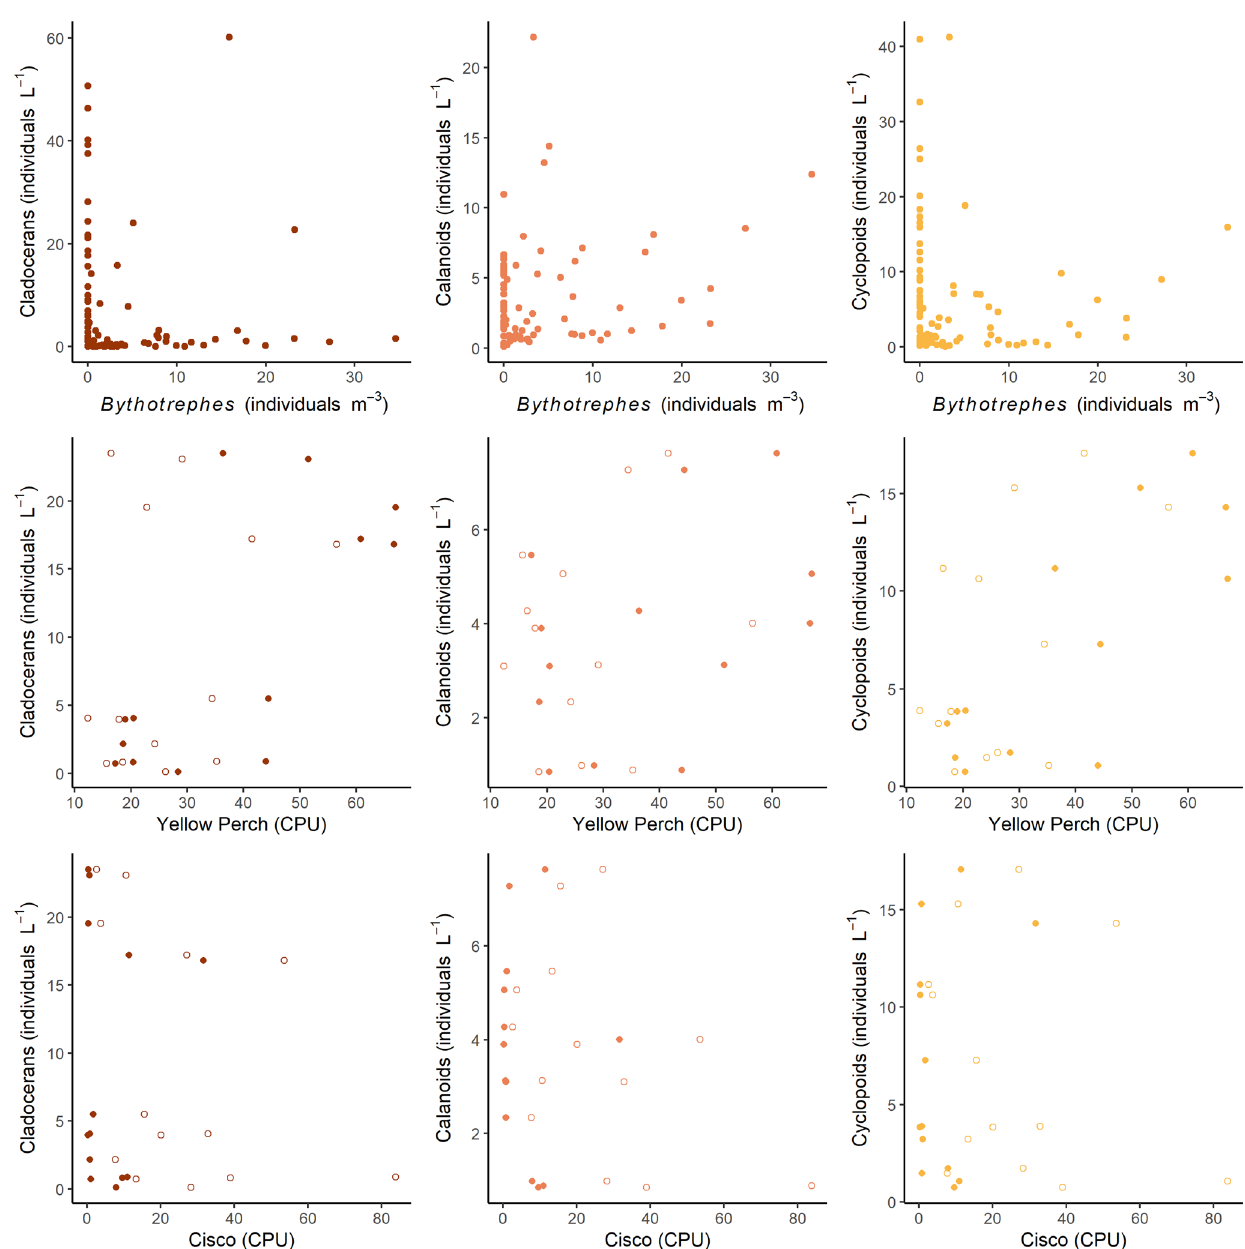
Fig. 5 Relationships (2006 – 2018) between abundances of native zooplankton groups (cladocerans, calanoids, and cyclopoids, individuals L – 1 ) and predators of zooplankton ( Bythotrephes , n = 87, individuals m – 3 ; yellow perch and cisco, n = 13 observation for each fi sh-location combination, CPU, catch per unit effort). Open symbols represent fi sh data from offshore gill nets, and closed symbols represent fi sh data from nearshore gill nets. The linear relationships between nearshore yellow perch and both cladocerans and cyclopoids were signi fi cant ( p = 0.0053 and 0.0011, r = 0.722 and 0.799,